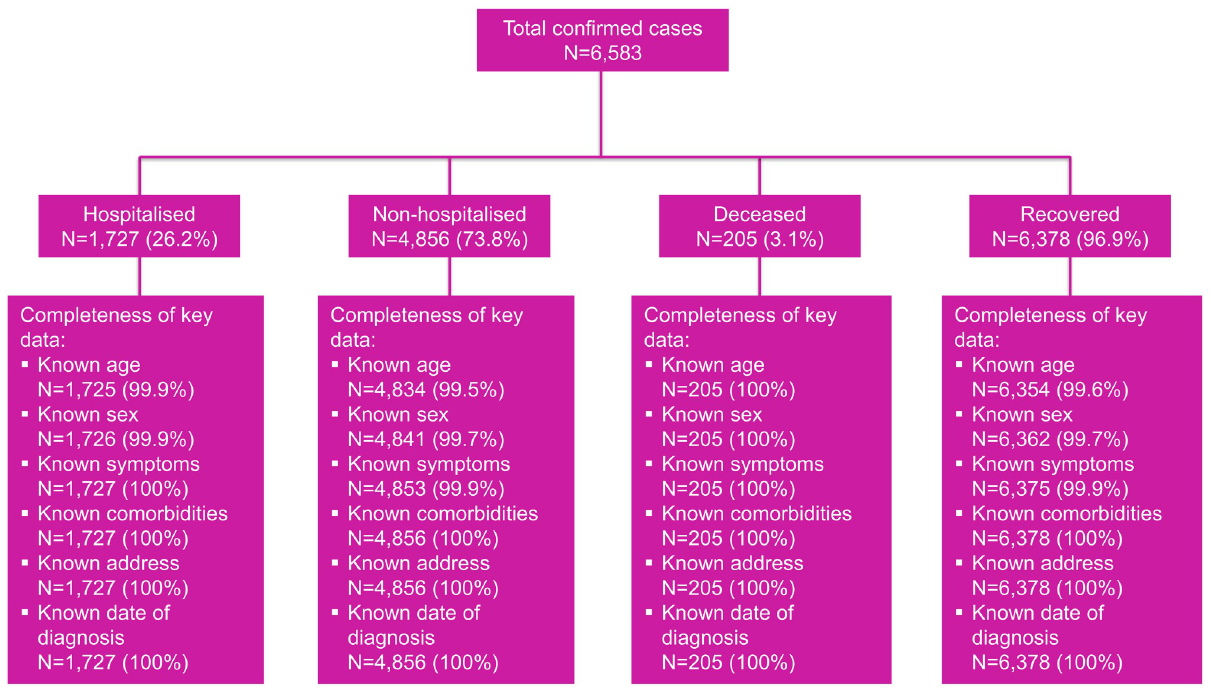
Fig 2. Study flow chart and completeness of key